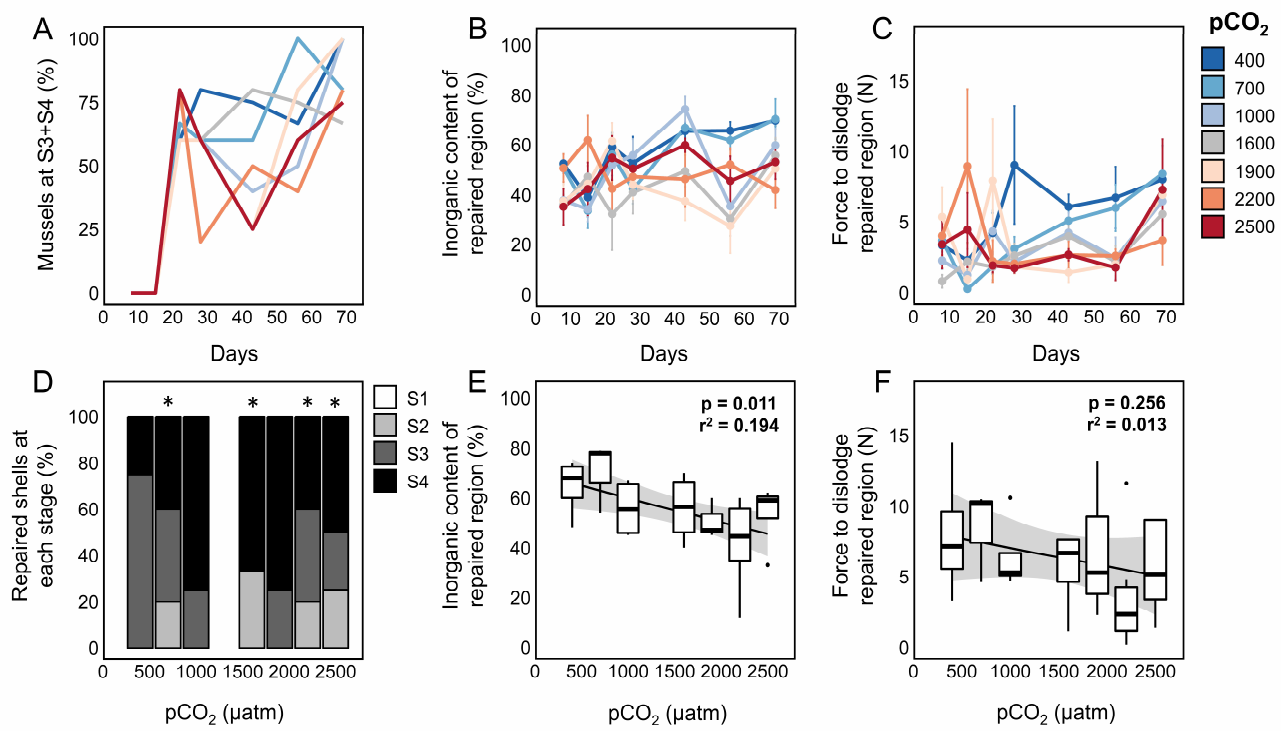
Figure 6. ( A ) Proportion of mussels ( M. trossulus ) that produced mineralized shell (reached S3 or S4) in response to shell damage within each OA treatment. ( B ) Inorganic content of excised repaired shell from mussels within each OA treatment. ( C ) The force required to dislodge repaired regions produced in each OA treatment. Proportion of mussels at each repair stage ( D ), the inorganic content of repaired regions ( E ), and force to dislodge repaired regions ( F ) after 10 weeks within each OA treatment. Data are from 4–8 mussels per treatment per time point. Asterisks mark treatments that were statistically different from the 400 µatm control.